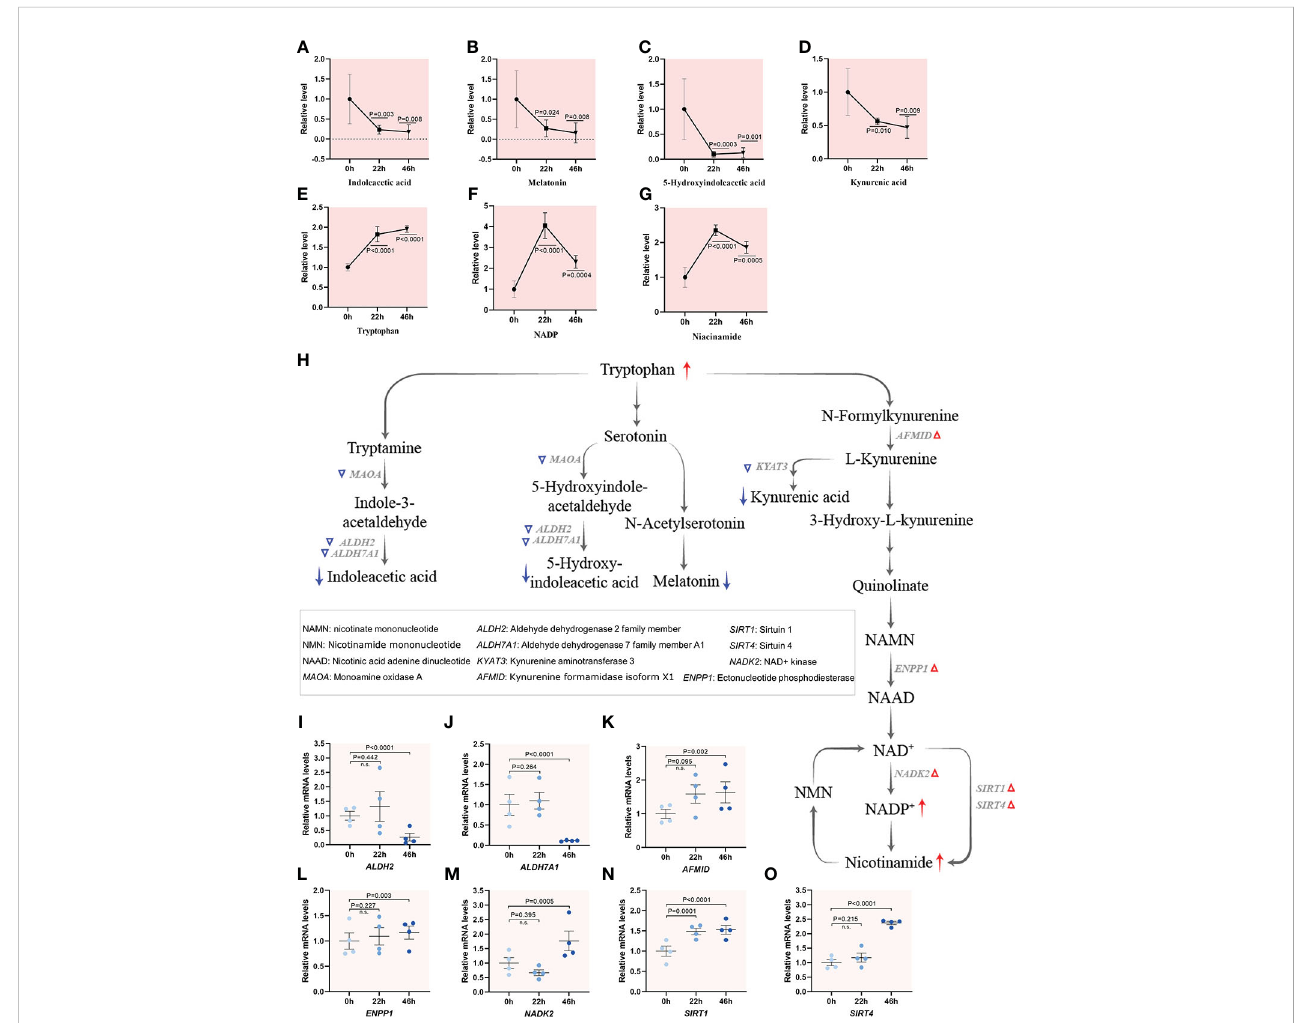
FIGURE 6 Tryptophan utilization during porcine oocyte maturation. (A – G) Relative levels of metabolites related to tryptophan metabolism in oocytes at three time points. (H) Schematic diagram of tryptophan metabolism during meiotic maturation, derived from metabolomics and transcriptomics. The red and blue arrows denote the metabolites that are upregulated and downregulated, respectively. DEGs increased and decreased are indicated by red and blue triangles, respectively. (I – O) Relative levels of representative differential expression genes involved in tryptophan utilization for maturation of porcine oocytes. Error bars, SD. Student ’ s t test was used for statistical analysis in all panels, comparing to GV. n.s., not signi fi